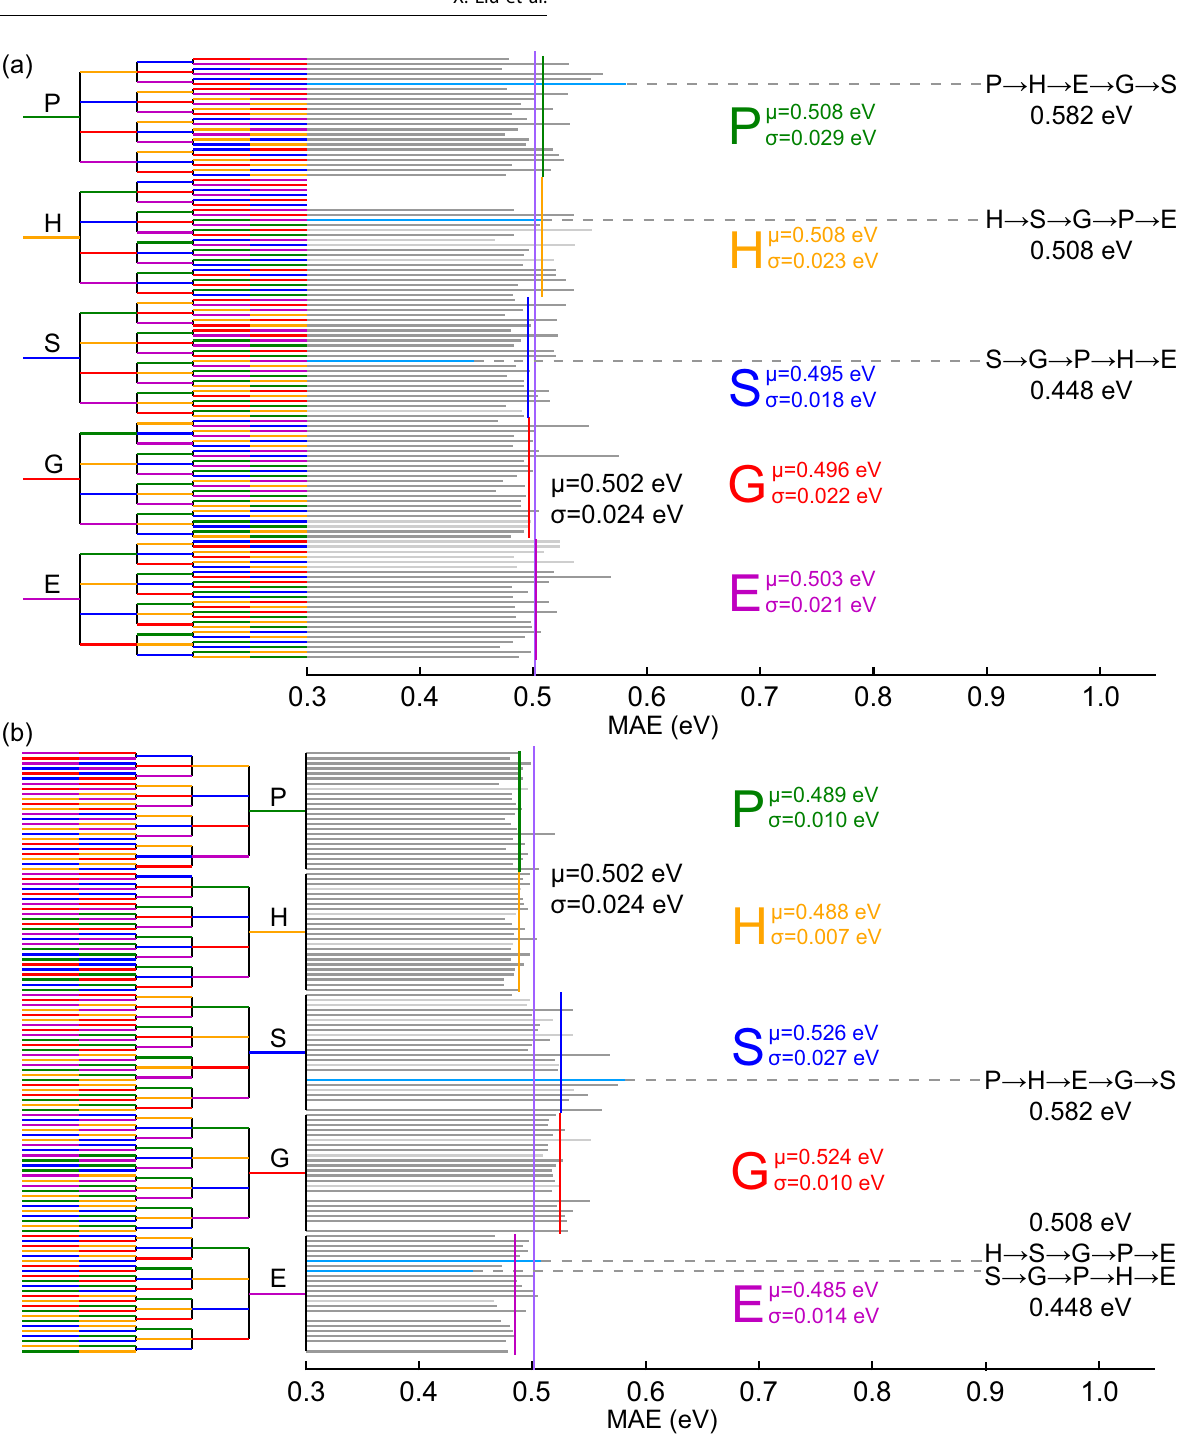
Fig. 7 MAE results on the cleaned data using the one-by-one training approach. All possible dataset sequences are gathered a according to the fi rst dataset used and b following the last dataset used. The data was cleaned using the best model of Fig. 5. The global average of the MAE is shown by a vertical solid purple line ( μ = 0.502 eV), while the group averages are indicated by their corresponding color (P in green, H in orange, S in blue, G in red, and E in magenta). The corresponding standard deviations ( σ ) are also indicated accordingly. The best and worst training sequences, as well as the worst one ending by E, are highlighted in light blue. The training sequences that produce NaN for one of the folds (so the MAE is only that of the other fold) are indicated by a lighter gray bar, while those that lead to NaN for both folds are left gap ( E g < 2) semiconductors (hexagons in Fig. 2), MFGNet shows a results as a function of the iteration for some representative better accuracy. training sequences. PHSGE → PHSE → HSE → HE → E) leads to the As already indicated, the cleaning procedure can be iterated lowest MAE (0.394 eV at the 6th iteration). Compared with one-by- toward convergence. In Fig. 10, we show the evolution of the one and all-together approaches, the onion training not only shows